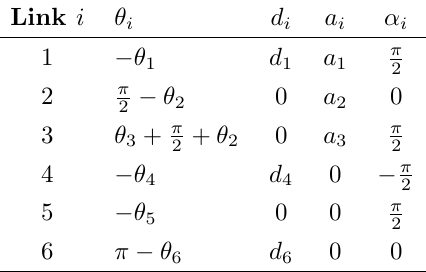
Table 2: DH table for the Comau Robot (6-DOF con- figuration) without extension arm.